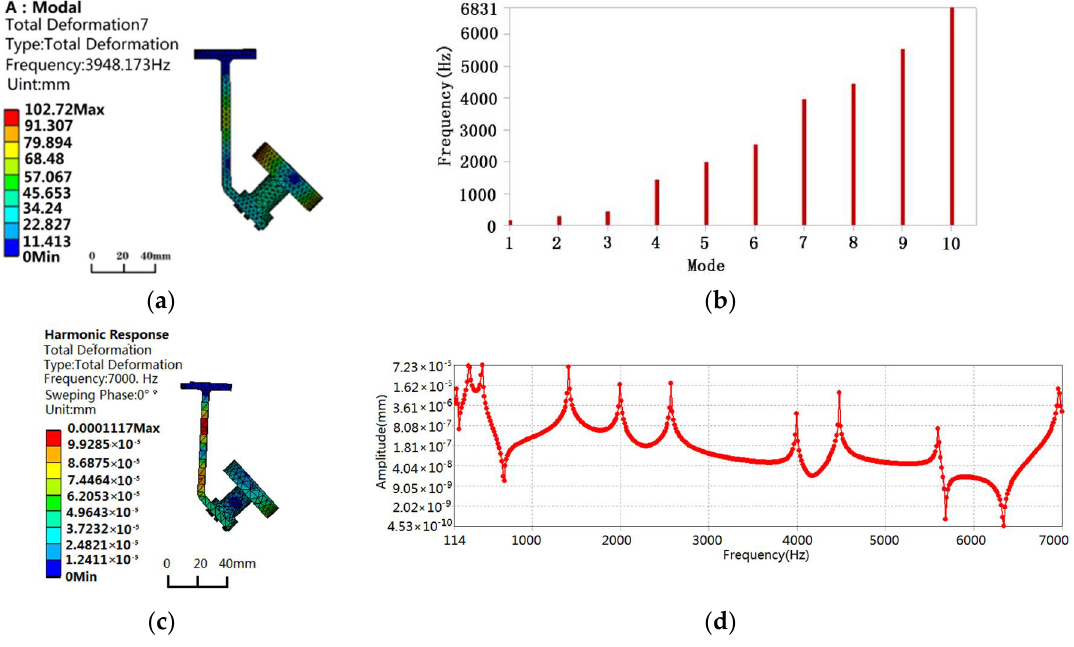
Figure 11. Vibration analysis of the FSM structure: ( a ) 7th order vibration mode, ( b ) 1st–10th order mode natural frequency, ( c ) strain analysis of harmonic response in 7000 Hz, and ( d ) frequency– displacement curve of harmonic